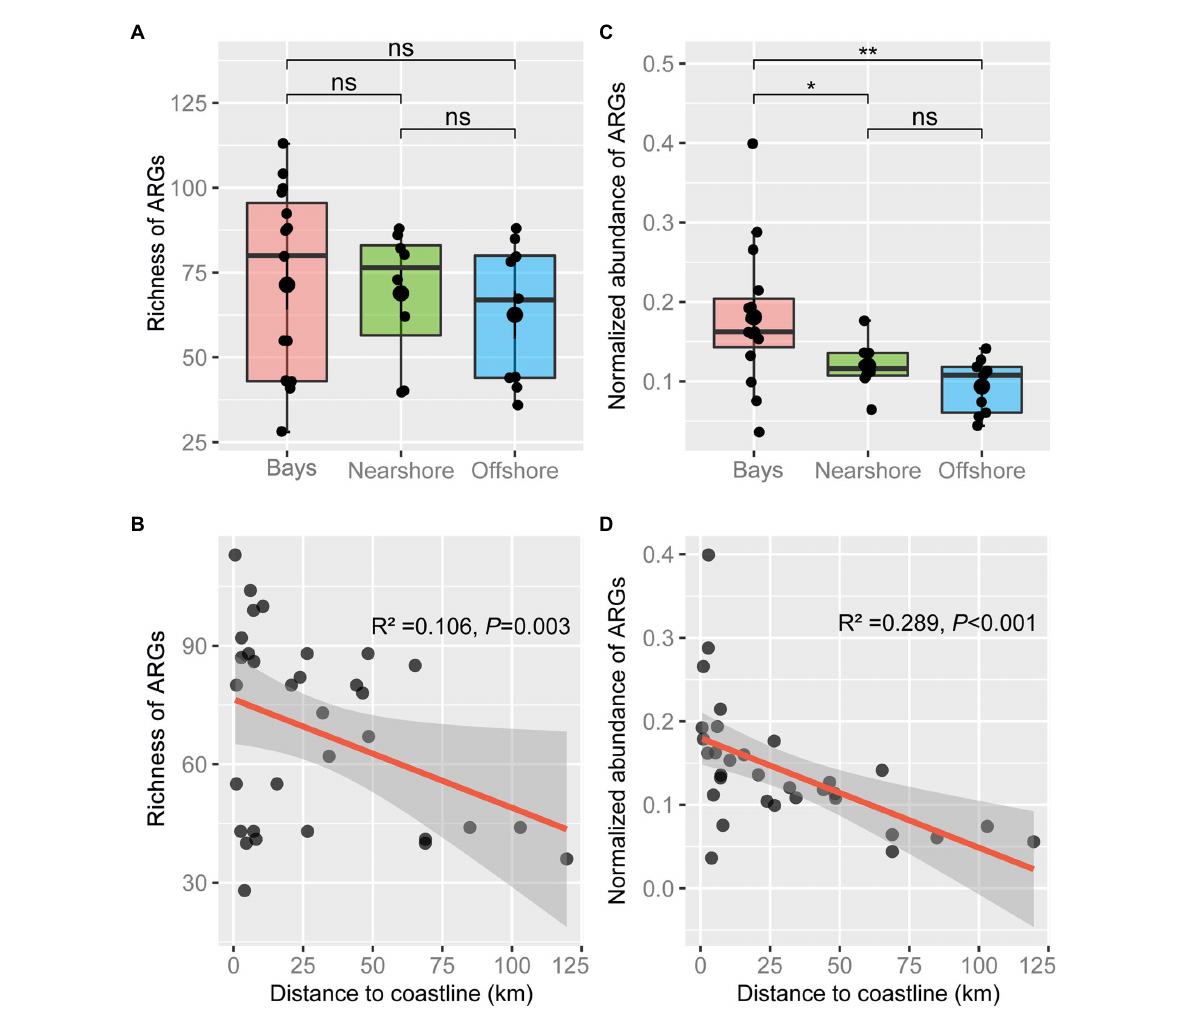
FIGURE 2 Characteristics of antibiotic resistomes across Bay, Nearshore, and Offshore areas. Boxplots showing the variation in richness (A) and normalized abundance (C) of antibiotic resistance genes (ARGs). Statistical significance was tested by Wilcoxon rank-sum test (* p < 0.05, ** p < 0.01, ns: not significant). The lower and upper hinges of the boxes correspond to the 25 th and 75 th percentiles. The lines in the boxes correspond to median. The upper whisker extends from the hinge to the value no further than 1.5IQR (inter-quartile range). The lower whisker extends from the hinge to the smallest value at most 1.5IQR. Data beyond the end of the whiskers are ‘outlying’ points. Correlations of richness (B) and normalized abundance (D) of ARGs with distance to coastline (DTC) were shown. The red line represents a linear fit with adjusted R 2 . The shaded area represents 95% confidence